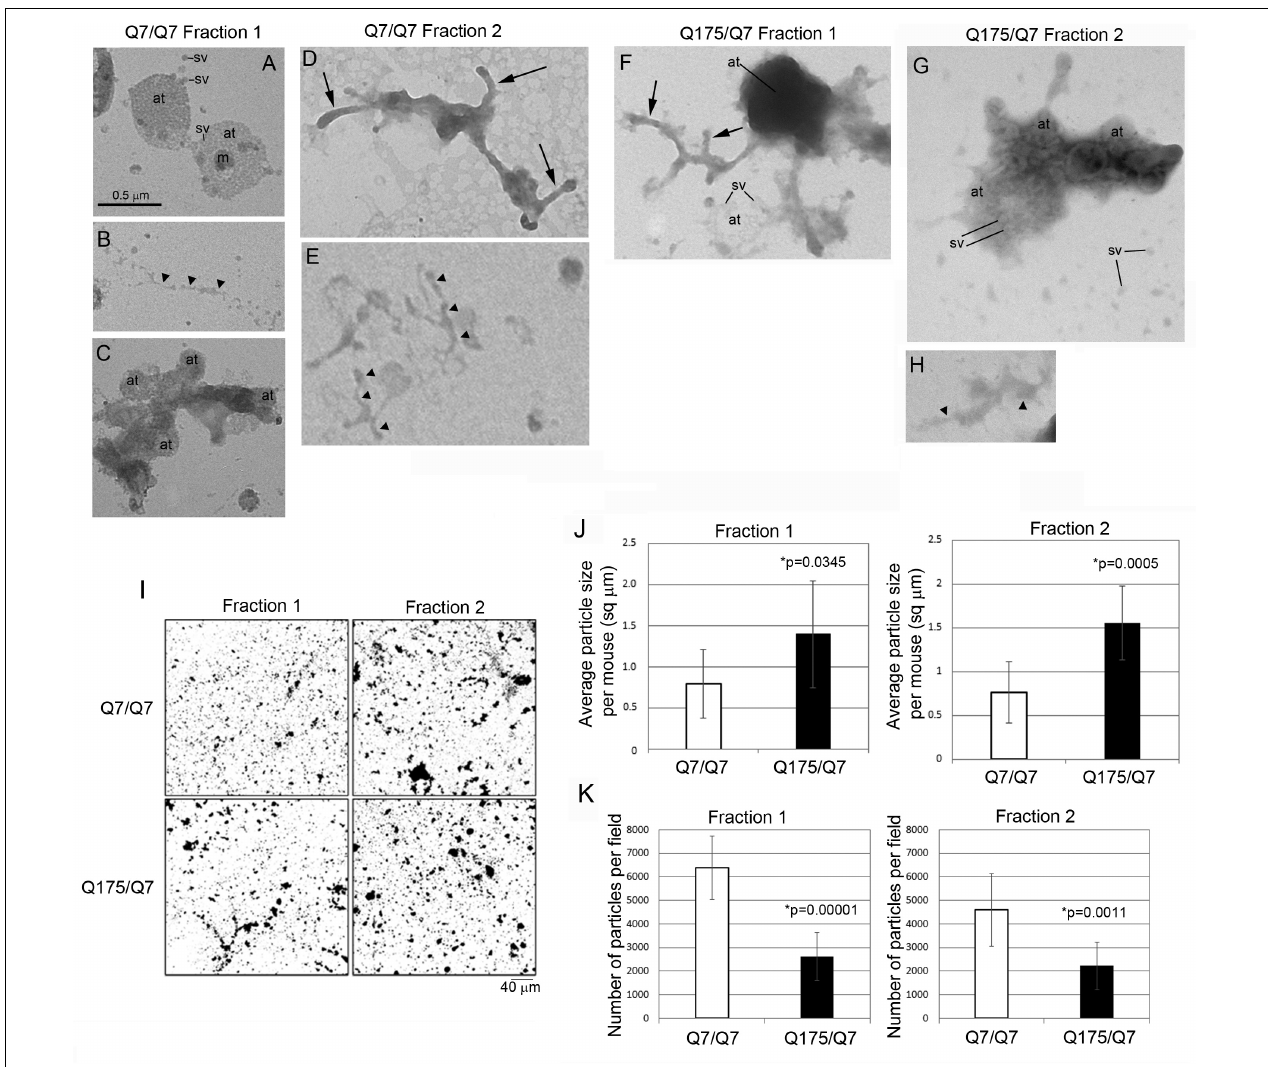
FIGURE 6 | Electron microscopic analysis of subcellular morphology and particle sizes and numbers in fractions 1 and 2. (A–H) EM images of fractions 1 and 2. Specimens for EM analysis were prepared and analyzed as described in section “Materials and Methods.” Sv, synaptic vesicle; at, axon terminal; arrowheads, tubular-vesicular membranes that may be ER or endosomes (B,E,H) ; arrows, preterminal axons and axon branches. Note that axon terminals (at) appear in groups in (A,C,F) , some are filled (axon terminals in A ) or partly filled with vesicles (lower axon terminal in F ) or overlap and appear electron dense (top axon terminal in F ). Synaptic vesicles (sv) appear inside the axon terminals and scattered outside the terminals (A,G) . Note in (G) that axon terminals have irregular shapes, electron dense cytoplasm, and some larger irregular shaped vesicles. Scale bar in A = 0.5 µ m and applies to all images. (I–K) Analysis of particle sizes and number in fractions 1 and 2. (I) shows representative electron microscope images of fractions 1 and 2 taken at 5,000 × that were used for quantification. Scale bar = 40 µ m and applies to all images. Data in (J,K) were obtained using ImageJ. Threshold was set for images on automatic settings using Renyi entropy method. Particles were excluded that were only 1 pixel. Students t -test was performed on N = 9 animals for each genotype. Bar graph in (J) shows mean particle size ± SD per mouse for Q7/Q7 and Q175/Q7 samples for fractions 1 and 2 ( ∗ p < 0.05, unpaired t -test, N = 9 mice, 7–45 images per mouse). There are significantly larger particles in Q175/Q7 samples compared to Q7/Q7 in fraction 1 and fraction 2. Bar graph in (K) shows number of particles ± SD per field for Q7/Q7 and Q175/Q7 samples for fractions 1 and 3 ( N = 9 mice, 7–45 image per mouse). There are significantly fewer particles in Q175/Q7 samples compared to Q7/Q7 in fraction 1 and fraction